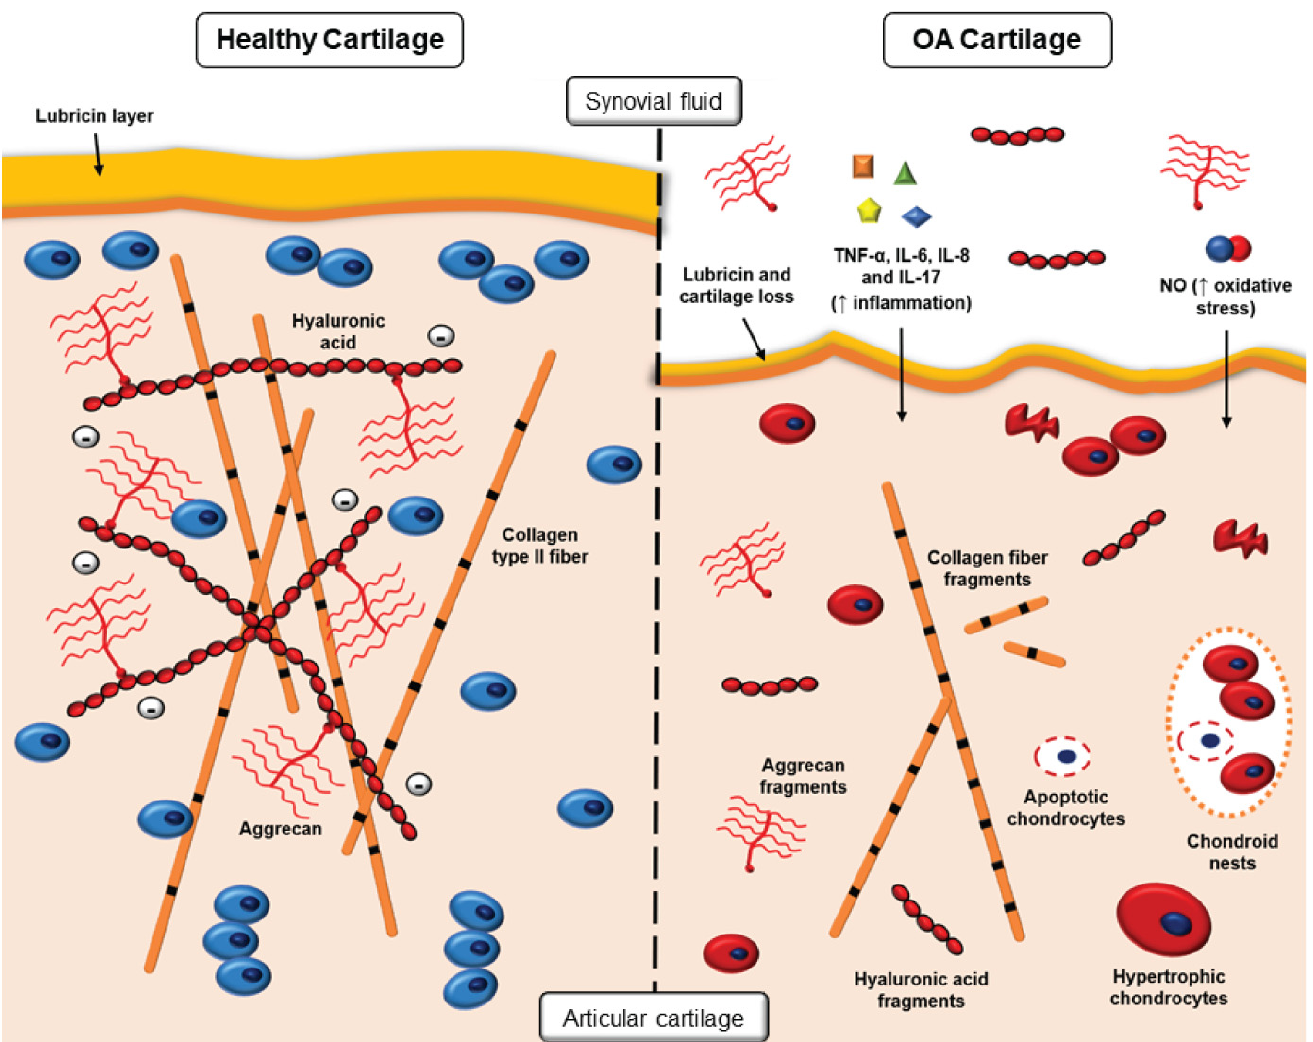
Figure 1. Healthy and osteoarthritic cartilage structure. In healthy cartilage, the fibrillar collagen network enriched in proteoglycans is a highly dense and negatively charged matrix. Osteoarthritis is a joint disorder involving the degeneration of articular cartilage, characterized by degradation of aggrecan proteoglycans by ADAMTS-4, loss and replacement of collagen type II by collagen type I, and increased apoptosis of chondrocytes; all these changes ultimately lead to the disturbance of cartilage homeostasis and loss of joint function. During OA, chondrocytes are exposed to pro- inflammatory cytokines mainly released by the synovial lining, such as TNF- α , IL-6, IL-8, and IL-17, as well as nitric oxide (NO), which increases oxidative stress in the joint. In the synovial fluid, other changes also occur, such as loss of lubricin and increased amounts of fragmented aggrecan because of the catabolism in the articular